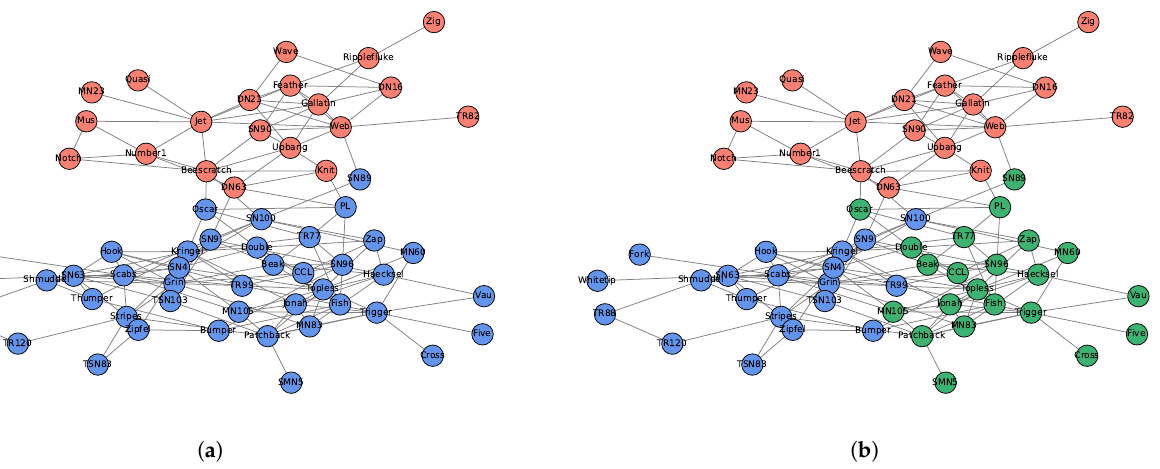
Figure 8. Community structure of the dolphin social network. ( a ) Two communities detected by [22]. ( b ) Inclusion probabilities of dolphin Grin’s local community. Colors correspond to the values in Figure 9.